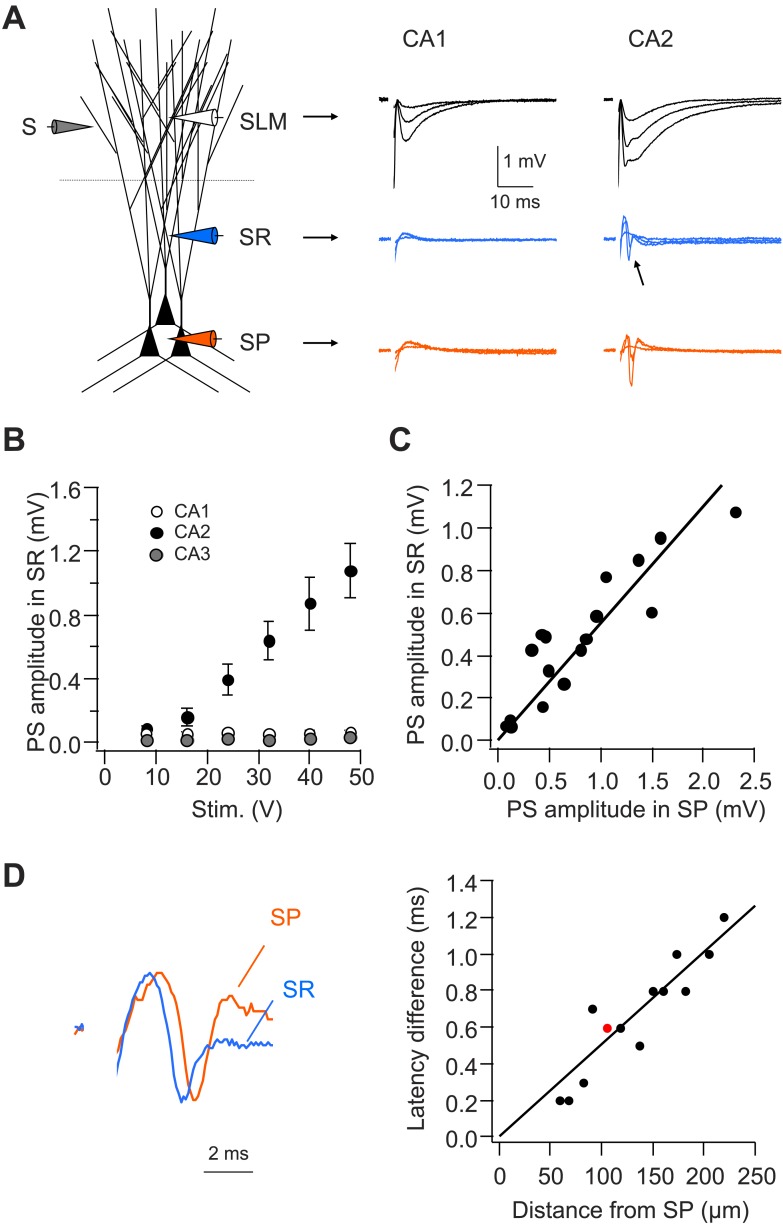
CA2, but not CA1 or CA3, dendrites are active in response to PP stimulation.(A) Left: diagram illustrating the configuration for extracellular field recording. Right: sample traces of field EPSP (fEPSP) responses in SLM, SR, and SP of CA1 and CA2 regions. Arrow indicates active dendritic response (negative field potential) in SR of CA2. (B) Mean input–output curves of PS amplitude in SR of CA1 (n = 4), CA2 (n = 7), and CA3 (n = 6) regions. (C) PS amplitude in SR plotted against PS amplitude in SP from the simultaneous field recordings in SR and SP in CA2 (correlation coefficient = 0.91, p < 0.001, n = 17). (D) Left: scaled simultaneously recorded field responses in SR and SP in CA2 (red circle in the right panel; distance from SP = 105 μm). Right: the time difference of the response latency between SR and SP plotted against the distance between the two recording electrodes (correlation coefficient = 0.92, p < 0.001, n = 13).